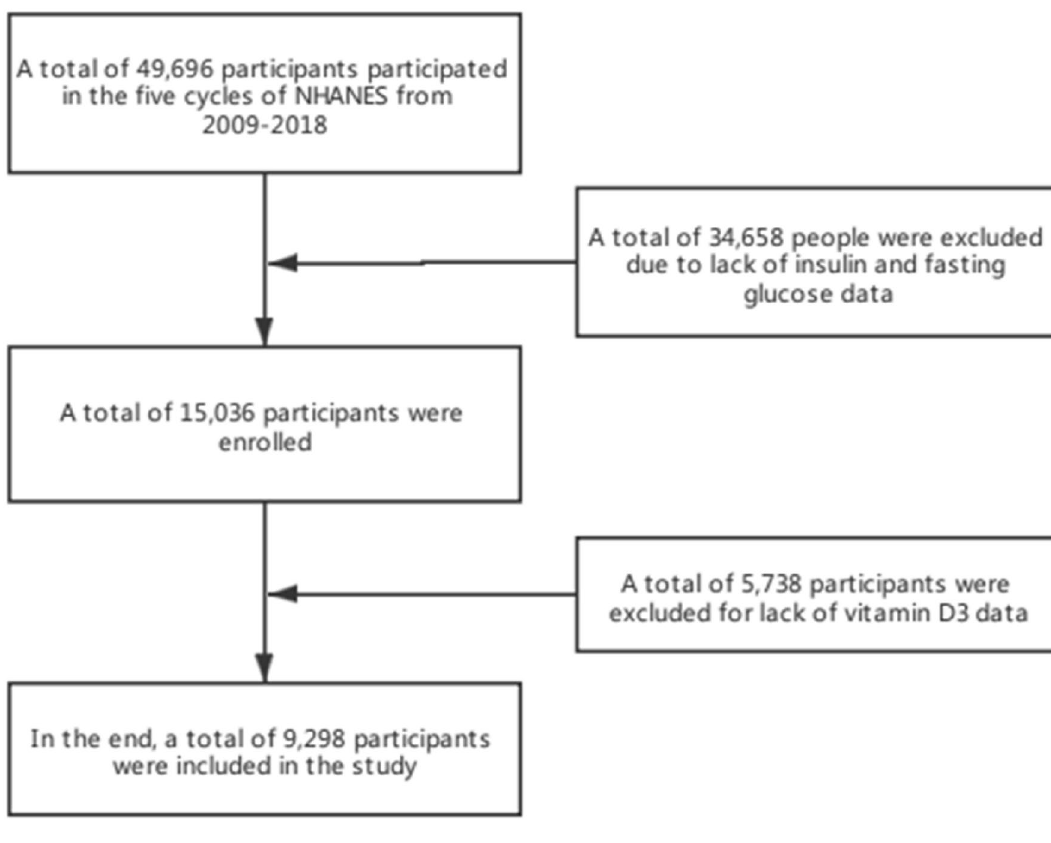
Figure 1. Flowchart of patient